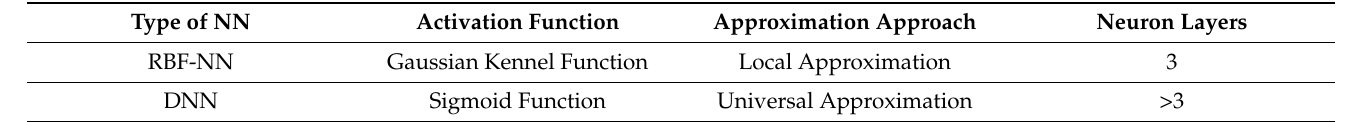
Table 2. Comparison of RBF-NN and DNN.